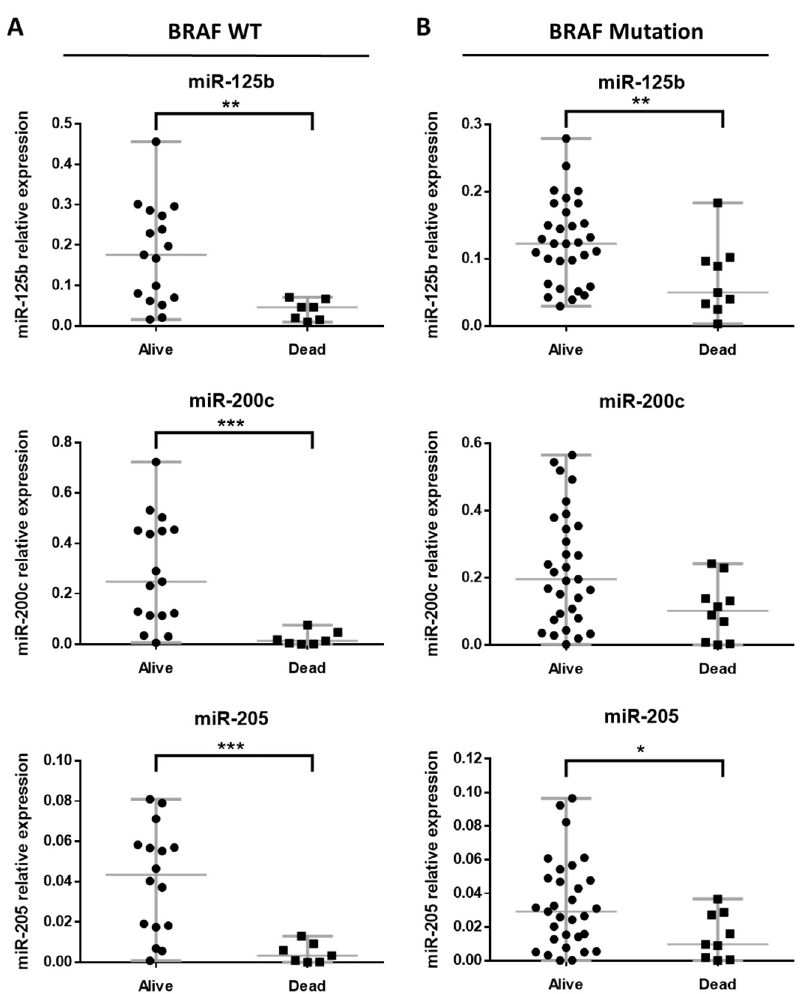
Figure 5. Association of relative expression of miR-125b, miR-200c and miR-205 in primary melanomas according to melanoma-specific death for ( A ) BRAF WT tumors and ( B ) any BRAF mutated tumors. Significant at * p -value < 0.05, ** p -value < 0.01 and *** p -value < 0.001. In the survival analysis, the BRAF WT primary melanoma population was dichotomized into patients with high or low miR-125b, miR-200c or miR-205 expression depending on their corresponding median values. In the Kaplan–Meier survival analysis, both melanoma-specific survival (MSS) and distant metastasis-free survival (DMFS) were sig- nificantly longer in patients with BRAF WT primary melanomas showing miR-125b (MSS rate = 100% vs. 48.98%, p -value = 0.0098 and DMFS rate = 88.89% vs. 48.98%, p -value = 0.0327), miR-200c (MSS rate = 100% vs. 48.98%, p -value = 0.0098 and